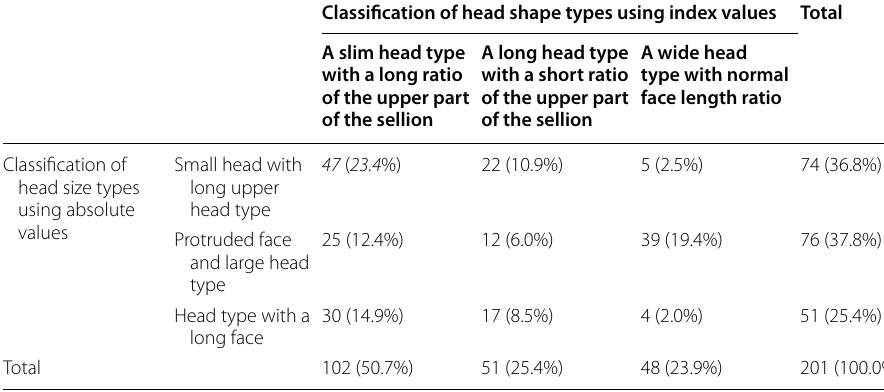
Table 8 Head type distribution in elderly women (unit:N, %)